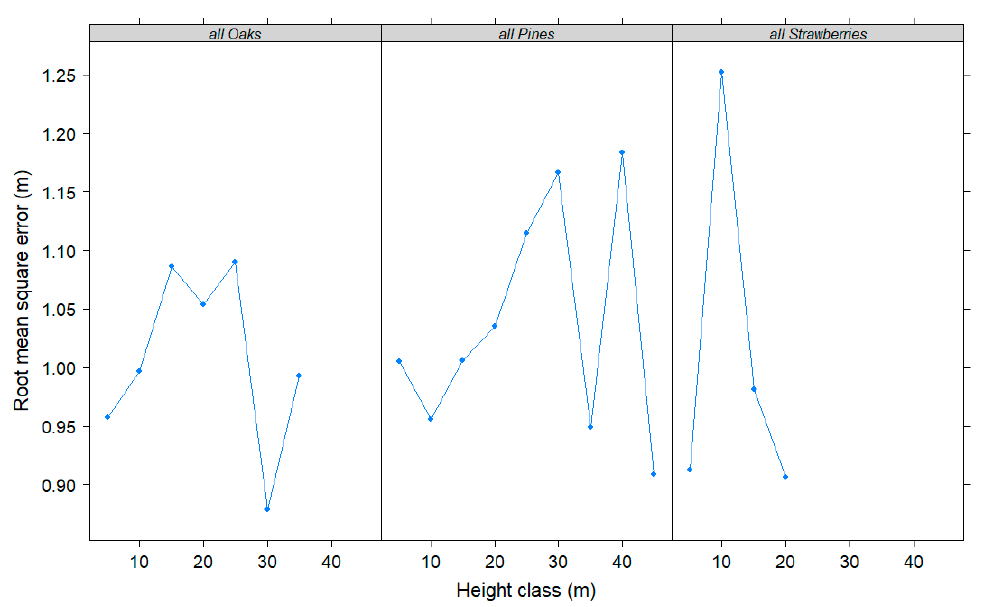
Figure 3. Root mean square error averaged over 5-m height classes for three generic individual height growth equations developed in this study.